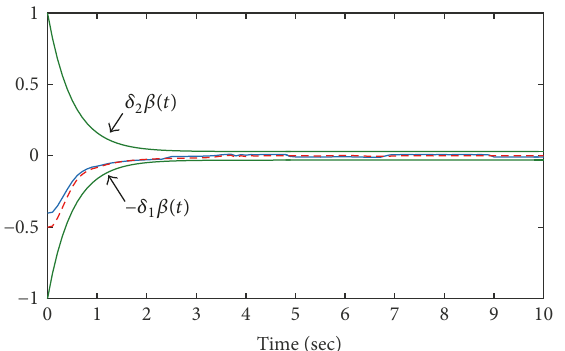
Figure 14: Tracking error: LC (-) of Baxter robot and LC (- -) of simulation.